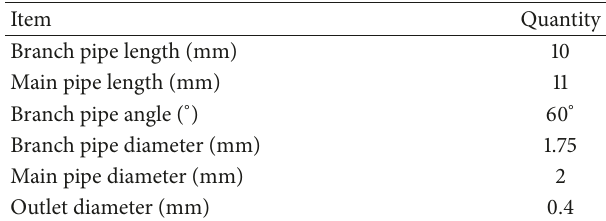
Table 1: Size of the simplified flow